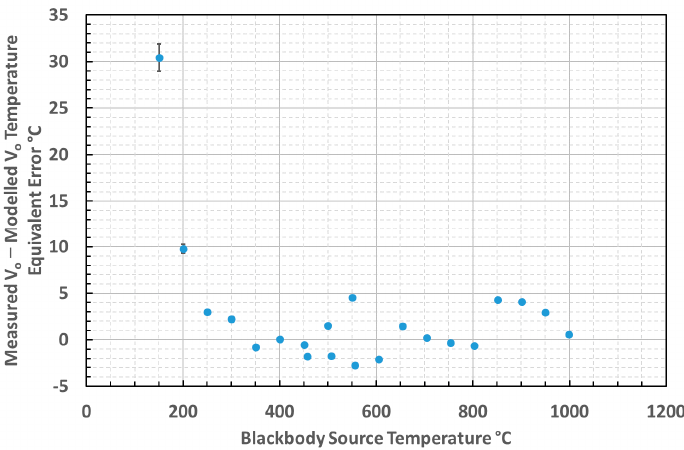
Figure 11. Temperature equivalent error between calculated and measured thermometer output.